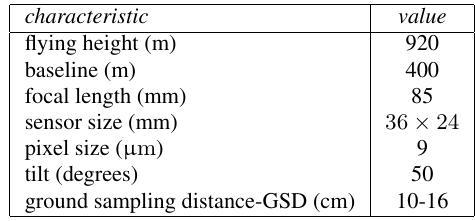
Table 1: Specification of oblique images from Pictometry Ground height and the building height were assessed with ALS data. These data were acquired in March 2007. The average point density of the laser data is 20 pts/m 2 (Vosselman, 2008) with height accuracy of 10 cm .